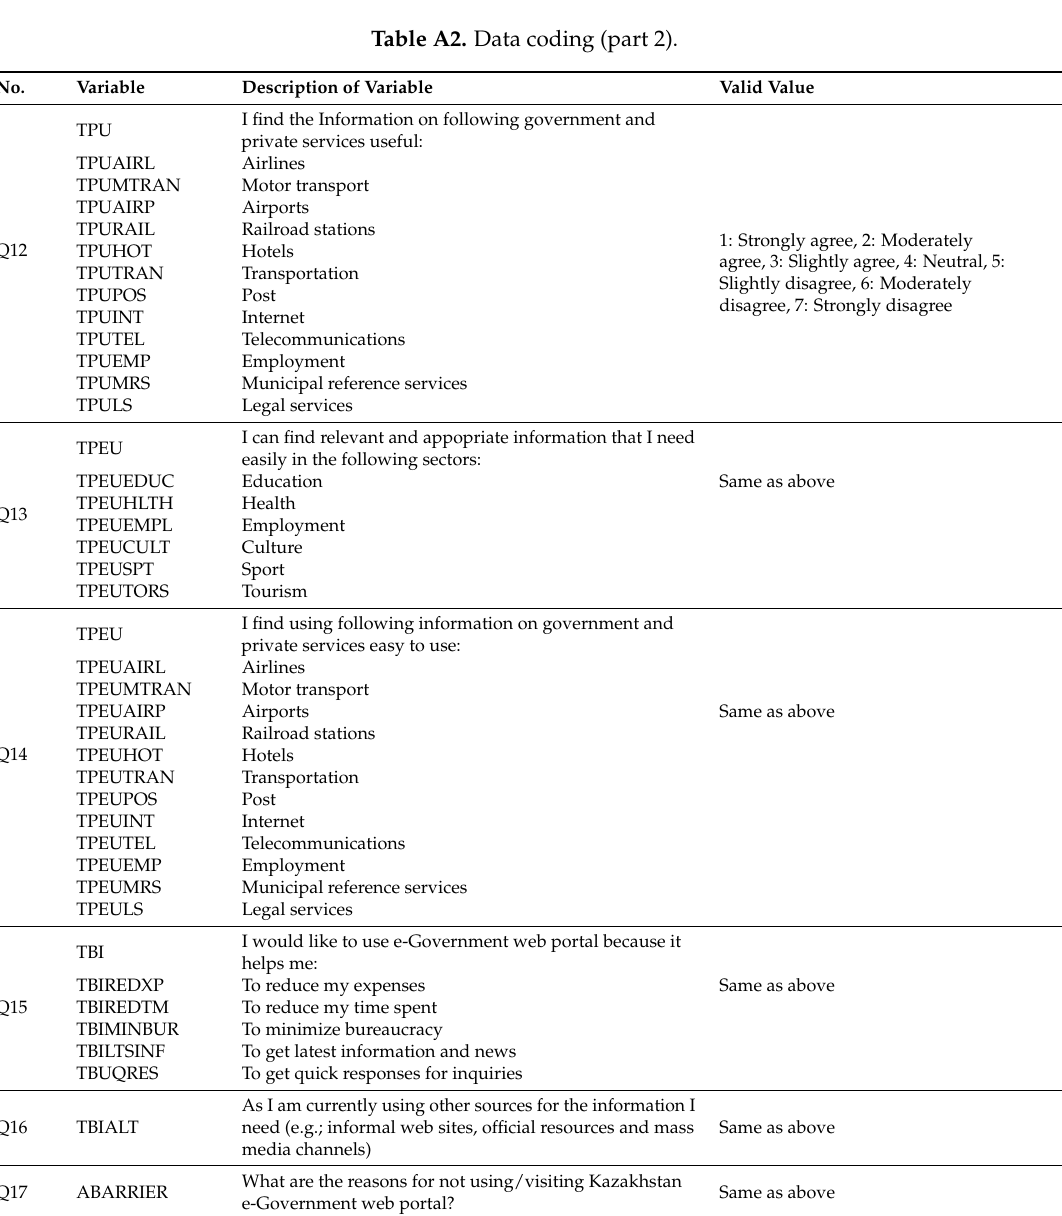
Table A2. Data coding (part